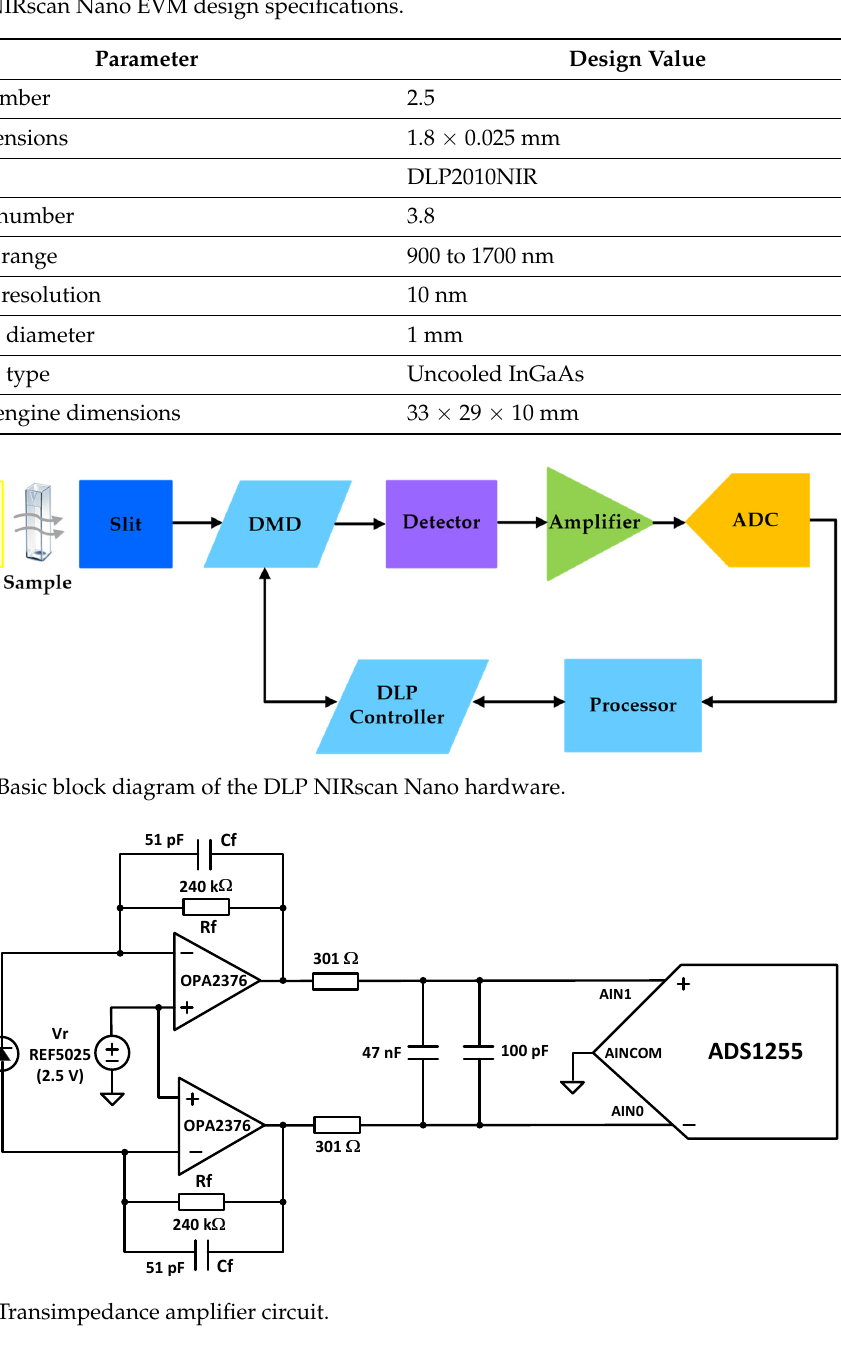
Figure 9. DLP NIRscan Nano GUI Scan Screen.